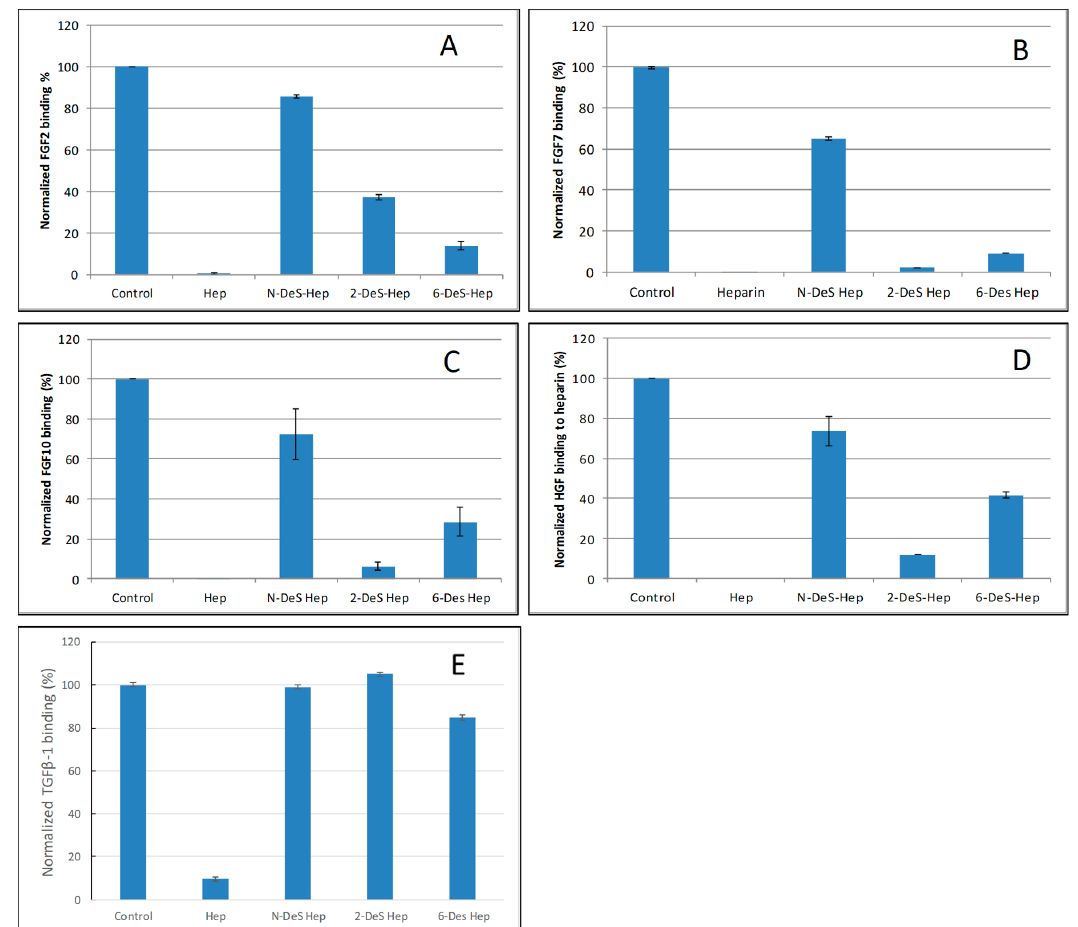
Figure 4. Bar graphs of normalized different growth factors binding preference to surface heparin by competing with different chemical modified heparin in solution. ( A ) FGF2, ( B ) FGF7, ( C ) FGF10, ( D ) HGF, ( E ) TGF β -1. Concentrations were 200, 100, 100, 20, and 50 nM for FGF2, FGF7, FGF10, HGF and TGF β -1, respectively, and concentrations of different modified heparin were 1000 nM. All bar graphs based on triplicate experiments.